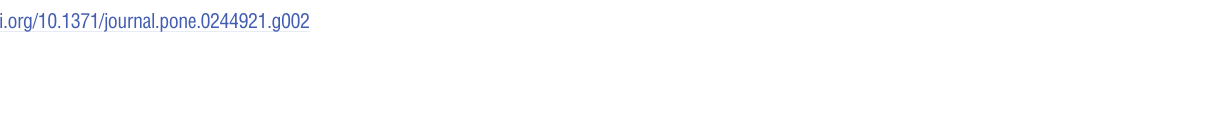
PLOS ONE | https://doi.org/10.1371/journal.pone.0244921 January 4,